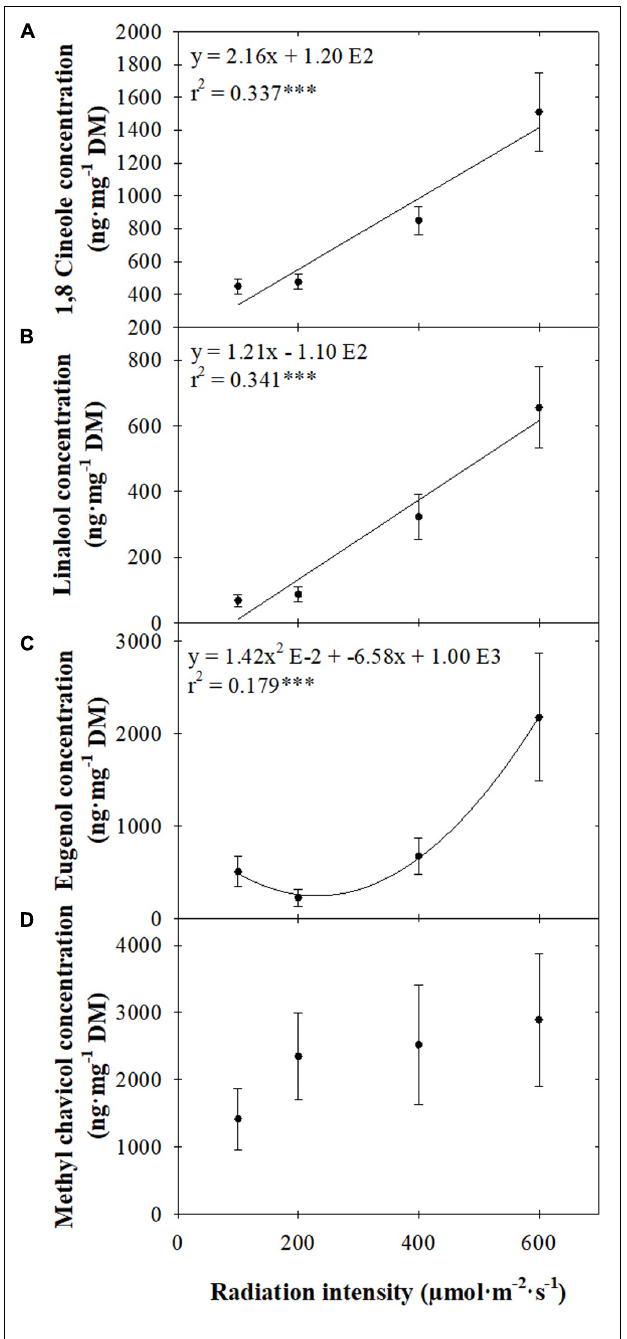
FIGURE 2 | Concentrations [ng · mg − 1 dry mass (DM)] of 1,8 cineole (A) , linalool (B) , eugenol (C) , and methyl chavicol (D) of sweet basil “Nufar” ( Ocimum basilicum ) seedlings grown under 100, 200, 400, or 600 µ mol · m − 2 · s − 1 photosynthetic photon flux density (PPFD) for 2 weeks. Each symbol represents the mean of 20 plants ± SE. Lines represent linear or quadratic regression. ***Significant at P ≤ 0.001.